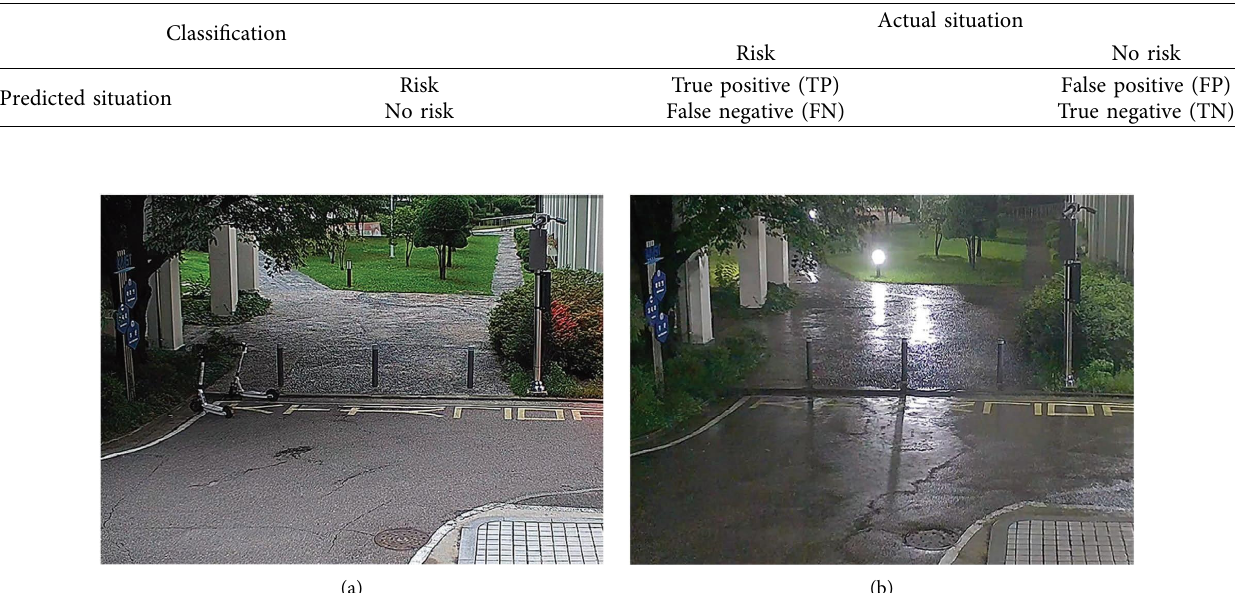
Table 1: Confusion matrix.